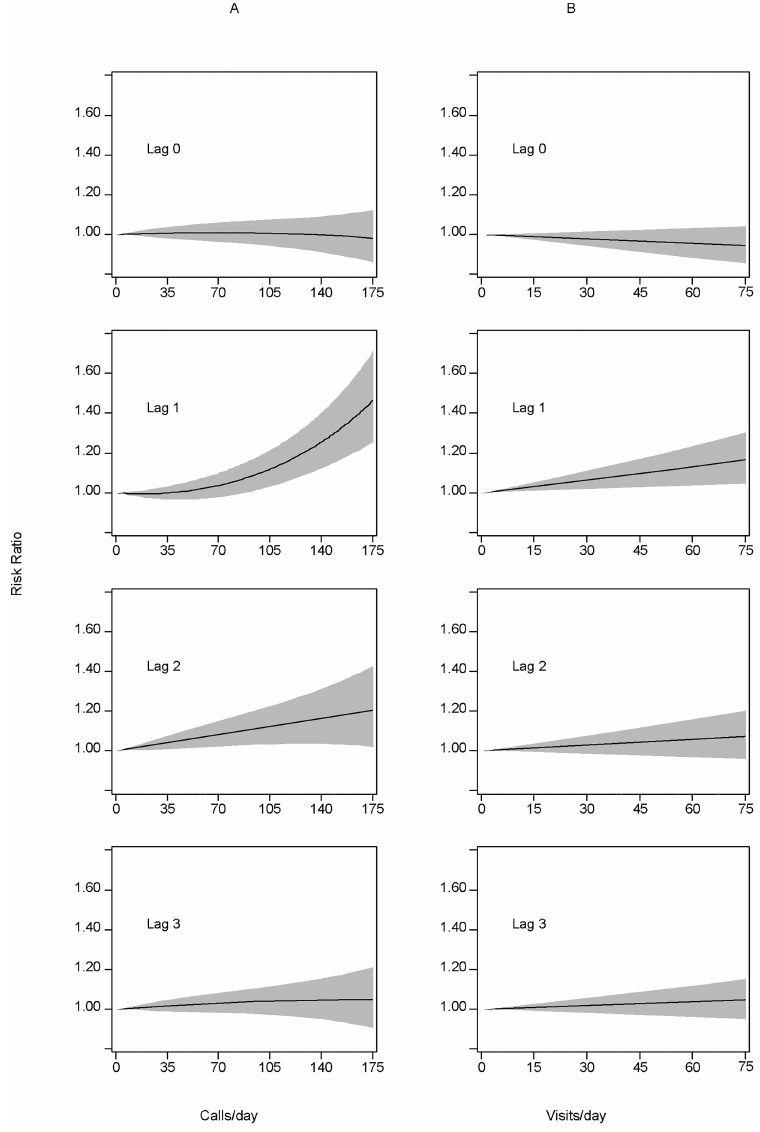
Fig 2. Relationship between non-external cause mortality lagged 0–3 days and heat-related (A) EMS calls and (B) ED visits for the weather-adjusted general linear models. Counts of heat-related EMS calls and ED visits are on the x-axis and risk ratio and 95% confidenceinterval are on the y-axis. (95% confidence interval (CI): 2–12) and 6% (95% CI: 3–10) increase in non-external cause mortality was associated with an increase from the 50 th percentile to 99 th percentile of same- day and one-day lagged heat-related EMS calls and ED visits, respectively. After fitting the full models adjusting for both temporal trends and weather (Fig 2), risk of non-external cause mortality increased 7% (95% CI: 3–12) with an increase from the 50 th percentile of one-day lagged heat-related EMS calls (n = 1) to the 99 th percentile (n = 60). At an increase from the 50 th percentile of one-day lagged heat-related ED visits (n = 2) to the 99 th percentile (n = 25), risk of non-external cause mortality increased 5% (95% CI: 2–8). We chose this range rather than the inter-quartile range given the distribution of heat-related EMS calls and ED visits